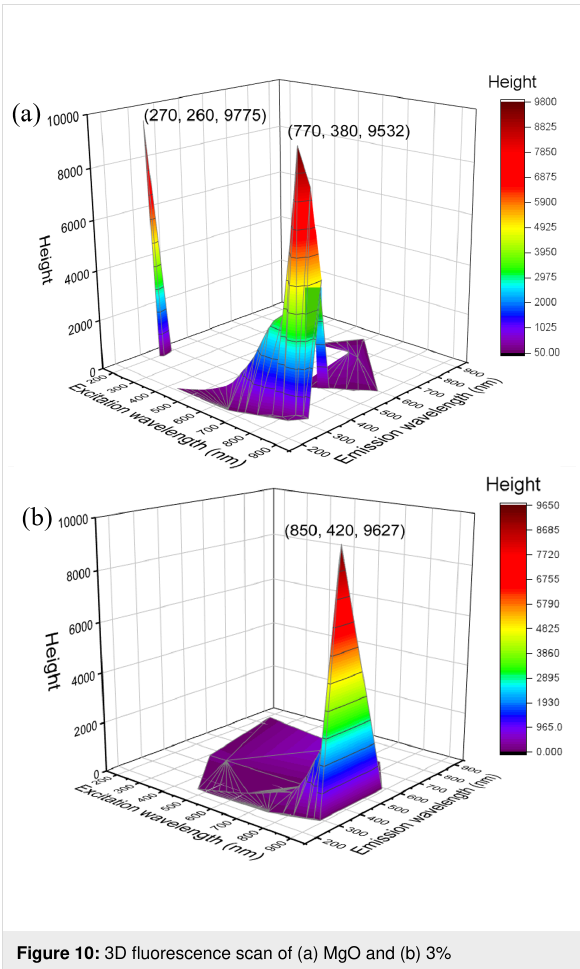
Figure 10: 3D fluorescence scan of (a) MgO and (b) 3% MgO@g-C 3 N 4